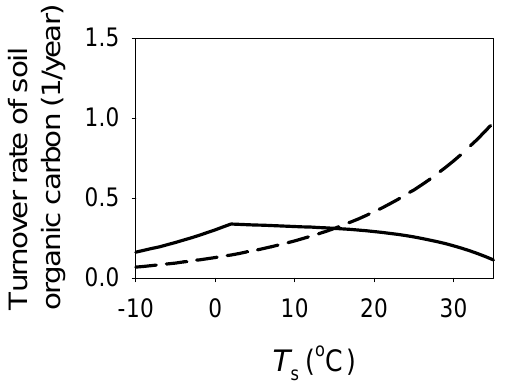
Fig. 7. Temperature dependence of the turnover rate of soil organic carbon decomposition with temperature-sensitive (solid curve) or temperature-insensitive (dashed curve) microbial growth efficiency of soil microbes in the three-pool model.